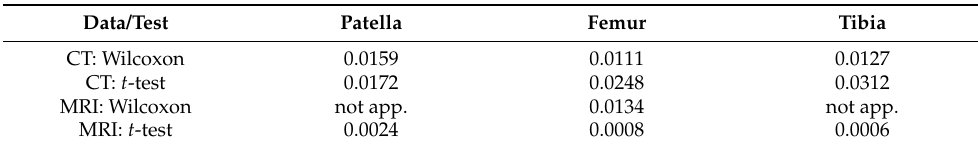
Table 7. p -values calculated for the Wilcoxon test and t -test for the following bones: patella, femur, and tibia.